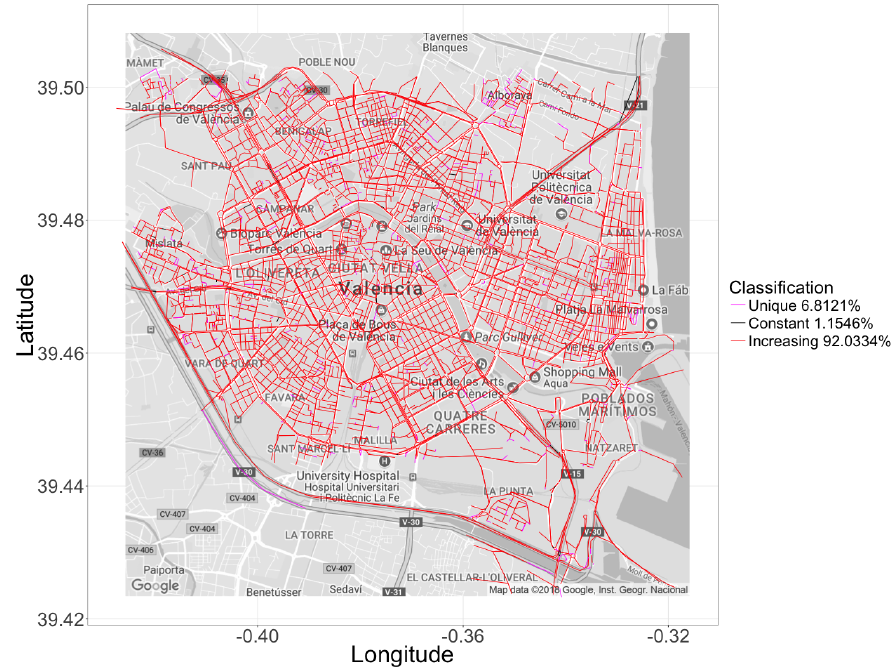
Figure 10. Geographical distribution of the segments